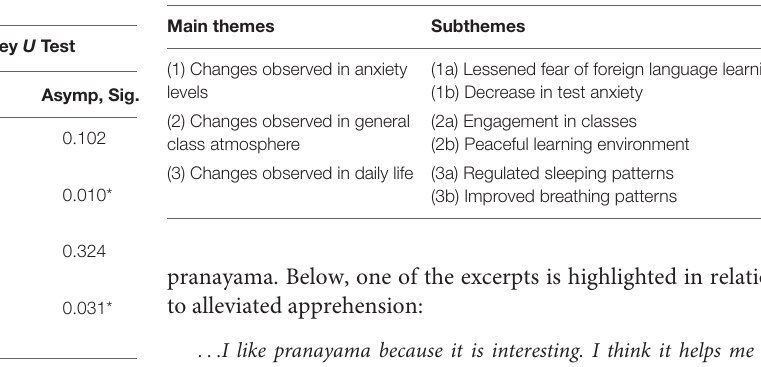
TABLE 7 | Semi-structured interview